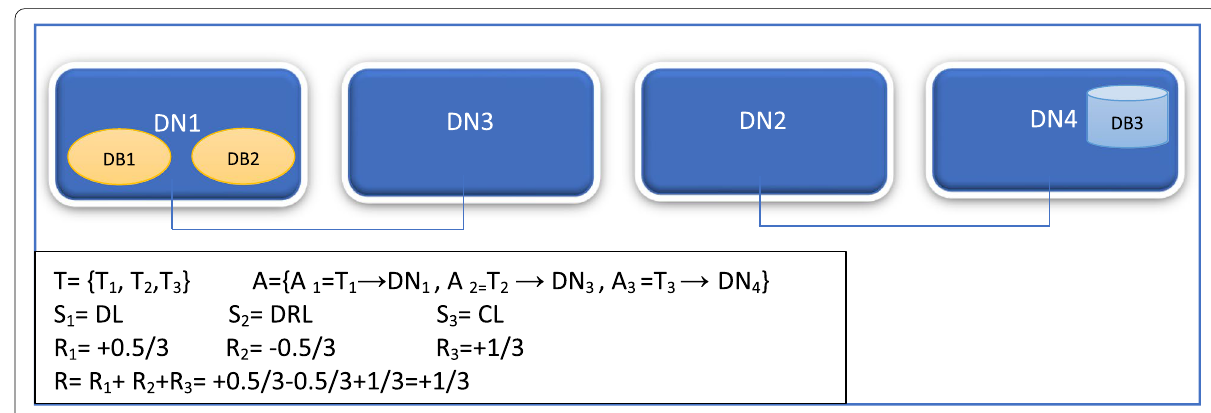
Fig. 2 An example of the CLQLMRS algorithm